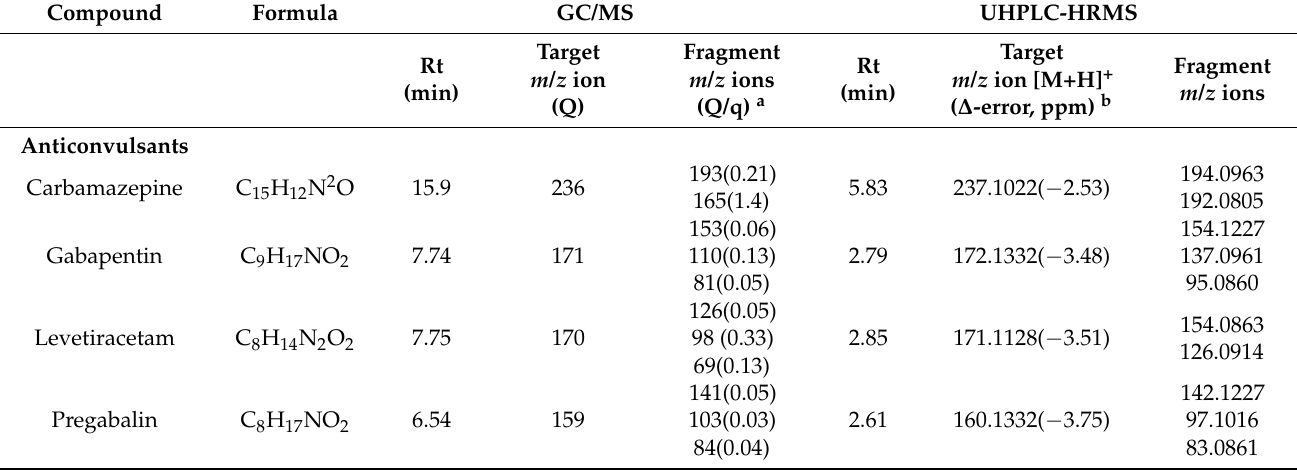
Table 1. List of different target compounds, retention times (Rt) and monitored ions ( m / z ) using for the screening gas chromatography-mass spectrometry (GC/MS) and ultra-high-performance liquid chromatography-high-resolution mass spectrometry (UHPLC-HRMS)